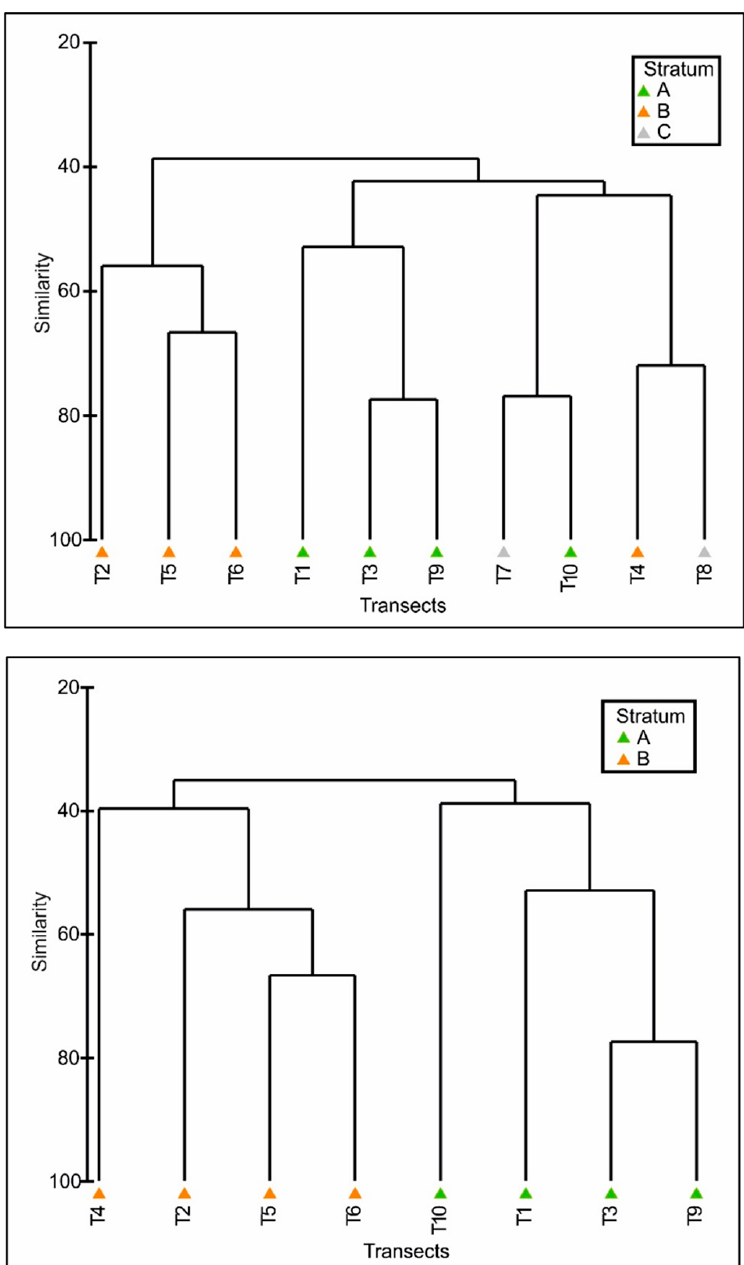
on the right) obtained through the Distance Sampling method between February and March 2019. Stratum A (in green): primary transitional moist forest; stratum B (in orange): secondary transi- tional dry forest. Altered transects (T7 and 78) are reported (stratum C; in grey) although not in- cluded in the habitat analysis. For each transect ( X -axis), values of the three replicates are shown (black dots).